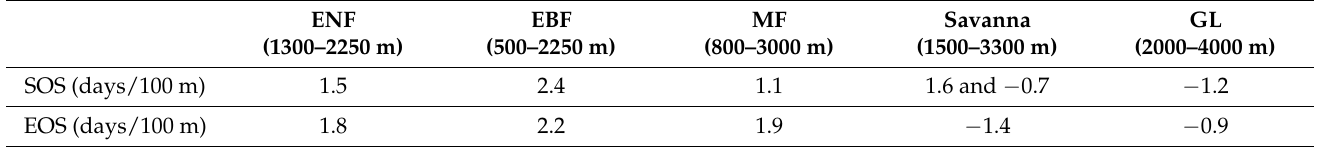
Table 1. Spatial distribution of phenometrics trend within vegetation